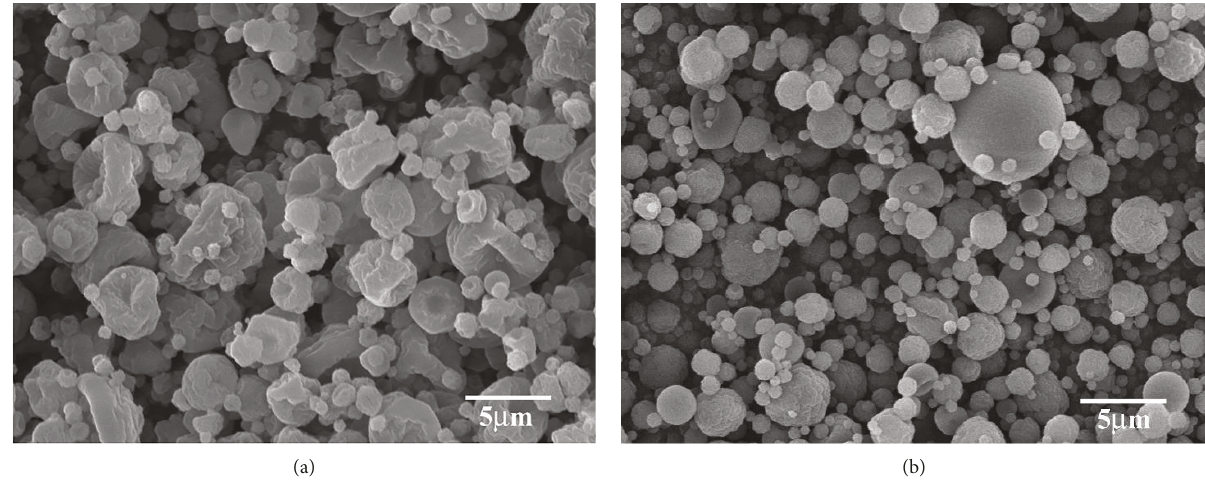
Figure 5: SEM image of the surface morphology of microparticles obtained by spray drying: (a) empty CS microspheres and (b) dexamethasone-loaded CS microspheres.